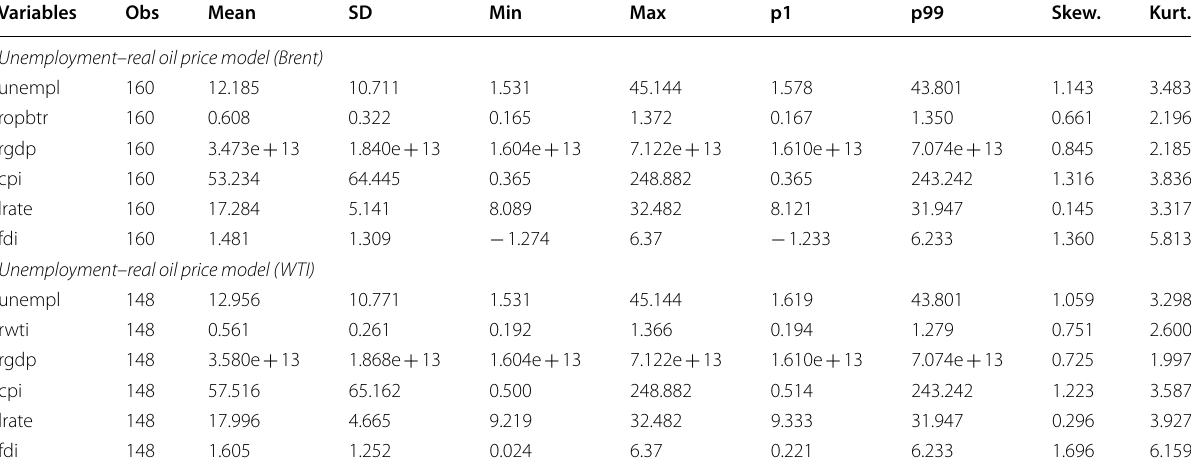
unempl, ropbtr, rwti, rgdp, cpi, lrate and fdi stand for unemployment rate, real brent oil price, real WTI oil price, real GDP, consumer price index, prime lending rate and foreign direct investment, respectively